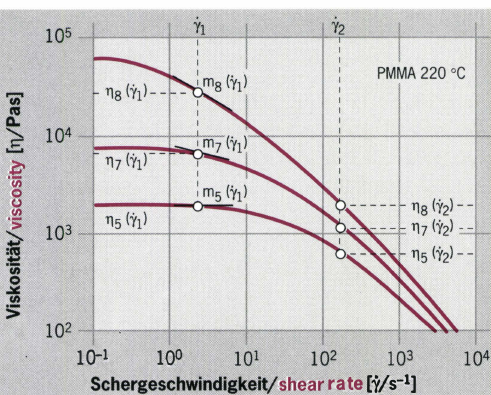
l: of the viscoelastic similar Plexiglas Viscosity functions ll ; IYI types BH, lN and 5N, with discrete viscosity values at